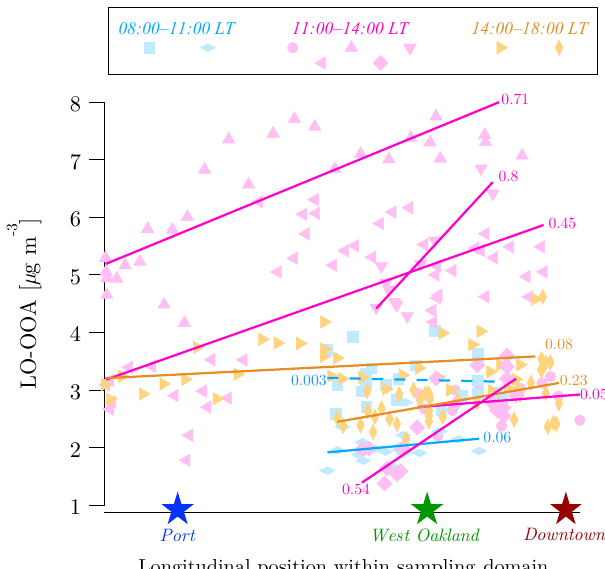
Figure 8. Spatial variations in measured LO-OOA on select intra- polygon transit drives on different days, colored by three different diurnal local time (LT) periods. Drives that reasonably spanned the longitudinal extent of the sampling domain with minimal latitudinal displacement were picked for this plot. Markers are individual LO- OOA samples and lines are fits for each transect drive. Fits that have a positive slope with proximity to downtown are shown as solid lines. The only fit that has a negative slope is shown as a dashed line. R 2 of fits are shown next to fits. Approximate locations of port, West Oakland, and downtown are shown as references to better visualize longitudinal positions of